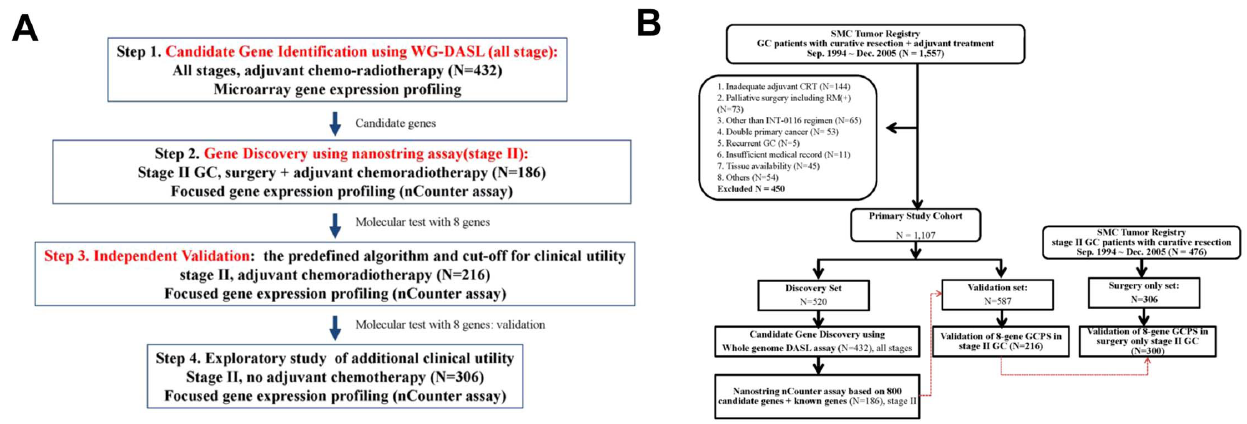
Figure 1. The Consort Diagram. (A) A multi-step approach gene expression profiling design, (B) Consort Diagram.